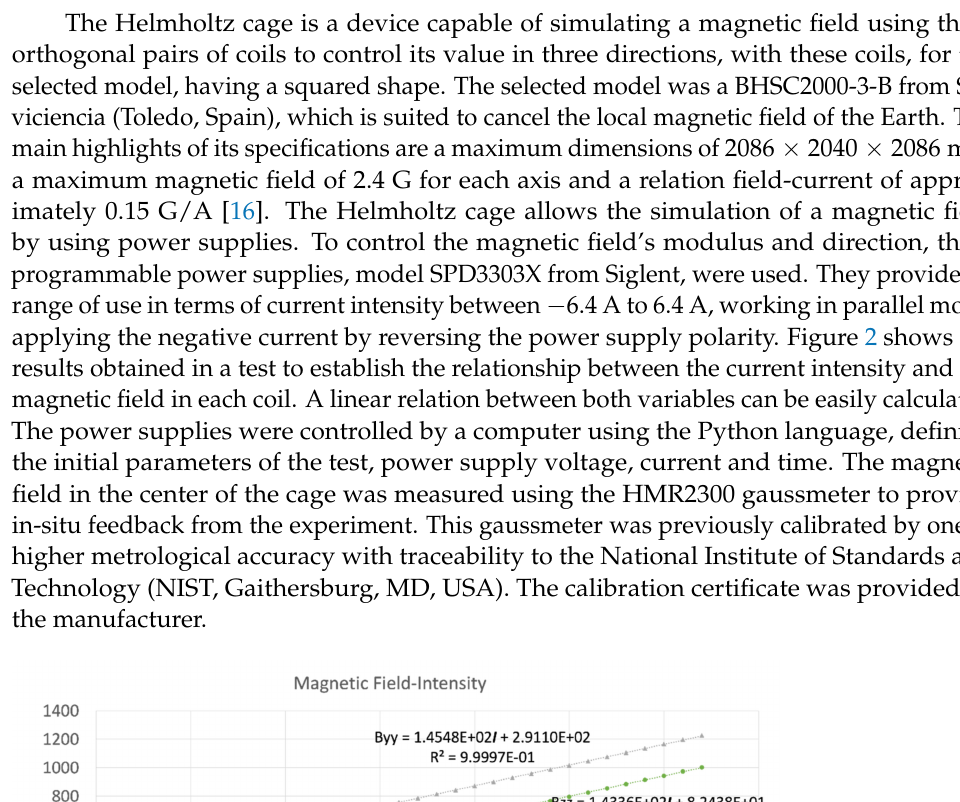
Figure 1. Testing facility scheme with components.